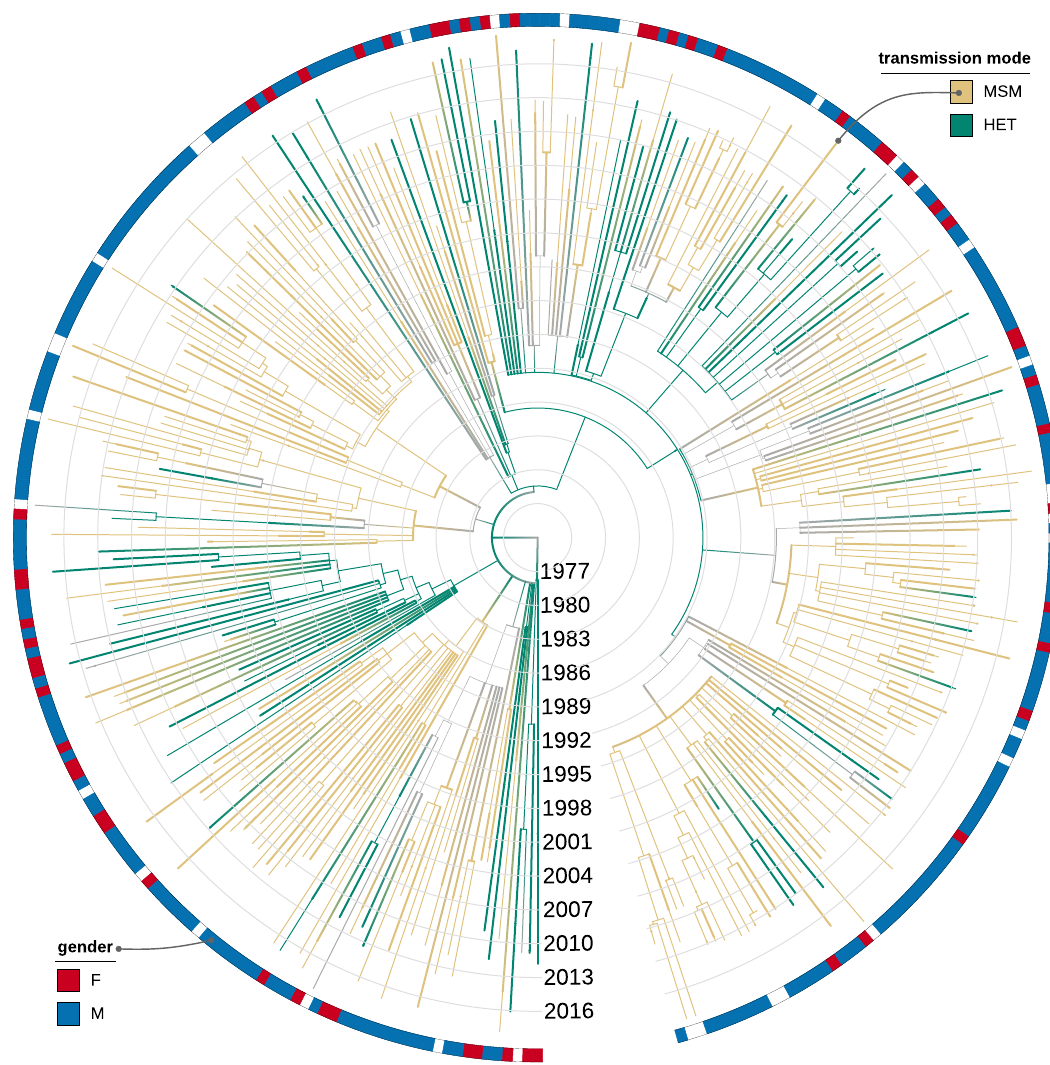
Fig 3. ACR for the transmission mode of CRF19. ACR is done with PastML [18] (MPPA+F81), the visualisation is performed with iTOL [19]. Nodes and branches are coloured by transmission mode (green for HET, beige for MSM), gray thinner branches correspond to a state change, gray nodes have unresolved states (MSM or HET). The colourstrip around the tree shows the gender of the sampled individuals (red for female, blue for male), and we see several transmissions from the MSM community to female HET